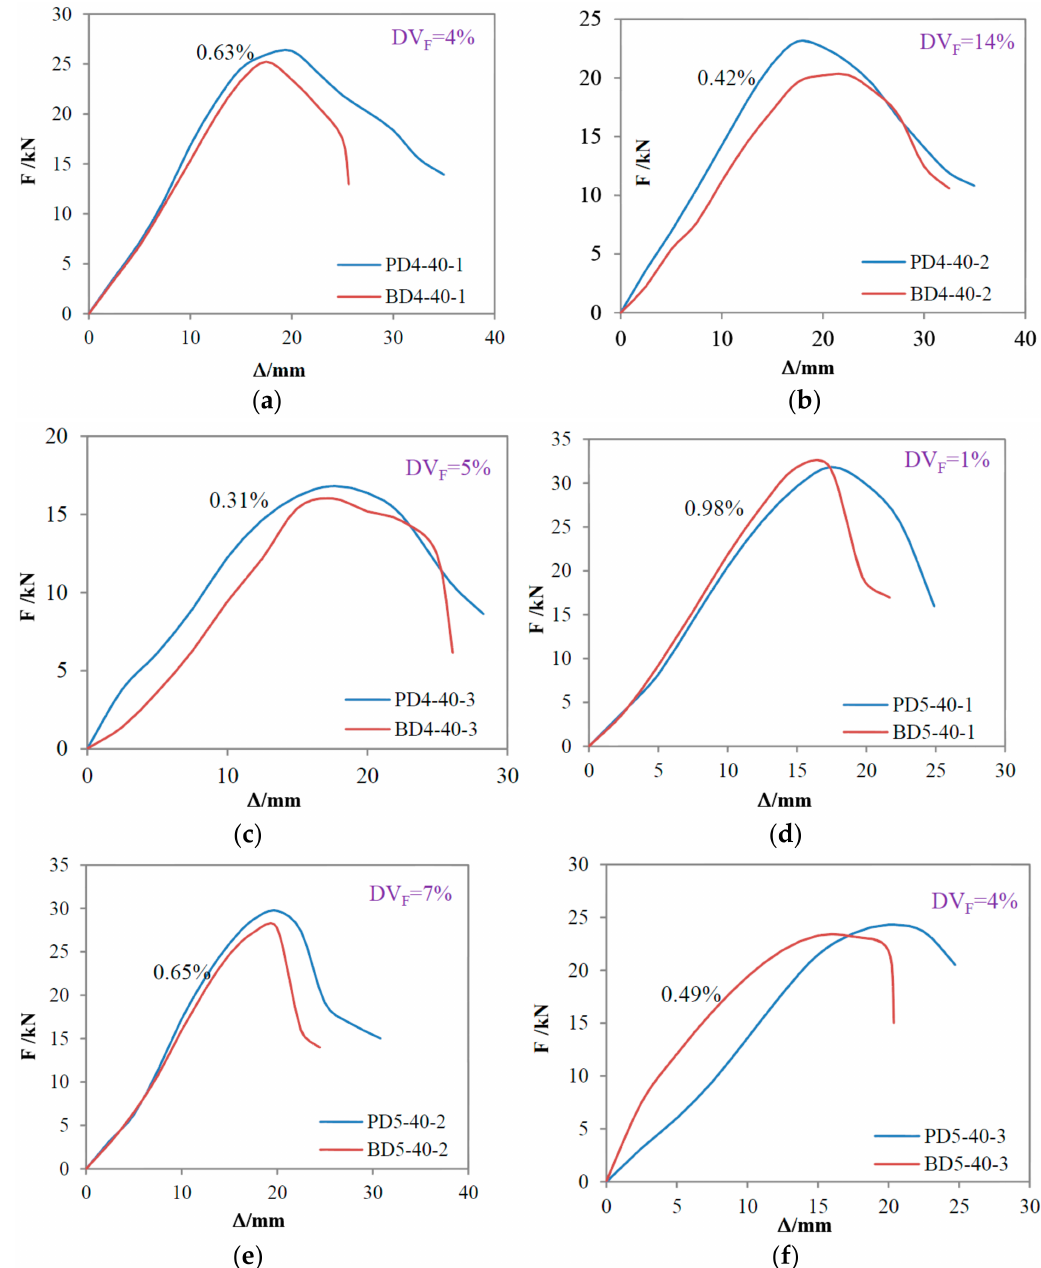
Figure 8. Influence of concrete material on bearing capacity of specimens. ( a ) Reinforcement ratio of 0.63%; ( b ) Reinforcement ratio of 0.42%; ( c ) Reinforcement ratio of 0.31%; ( d ) Reinforcement ratio of 0.98%; ( e ) Reinforcement ratio of 0.65%; ( f ) Reinforcement ratio of